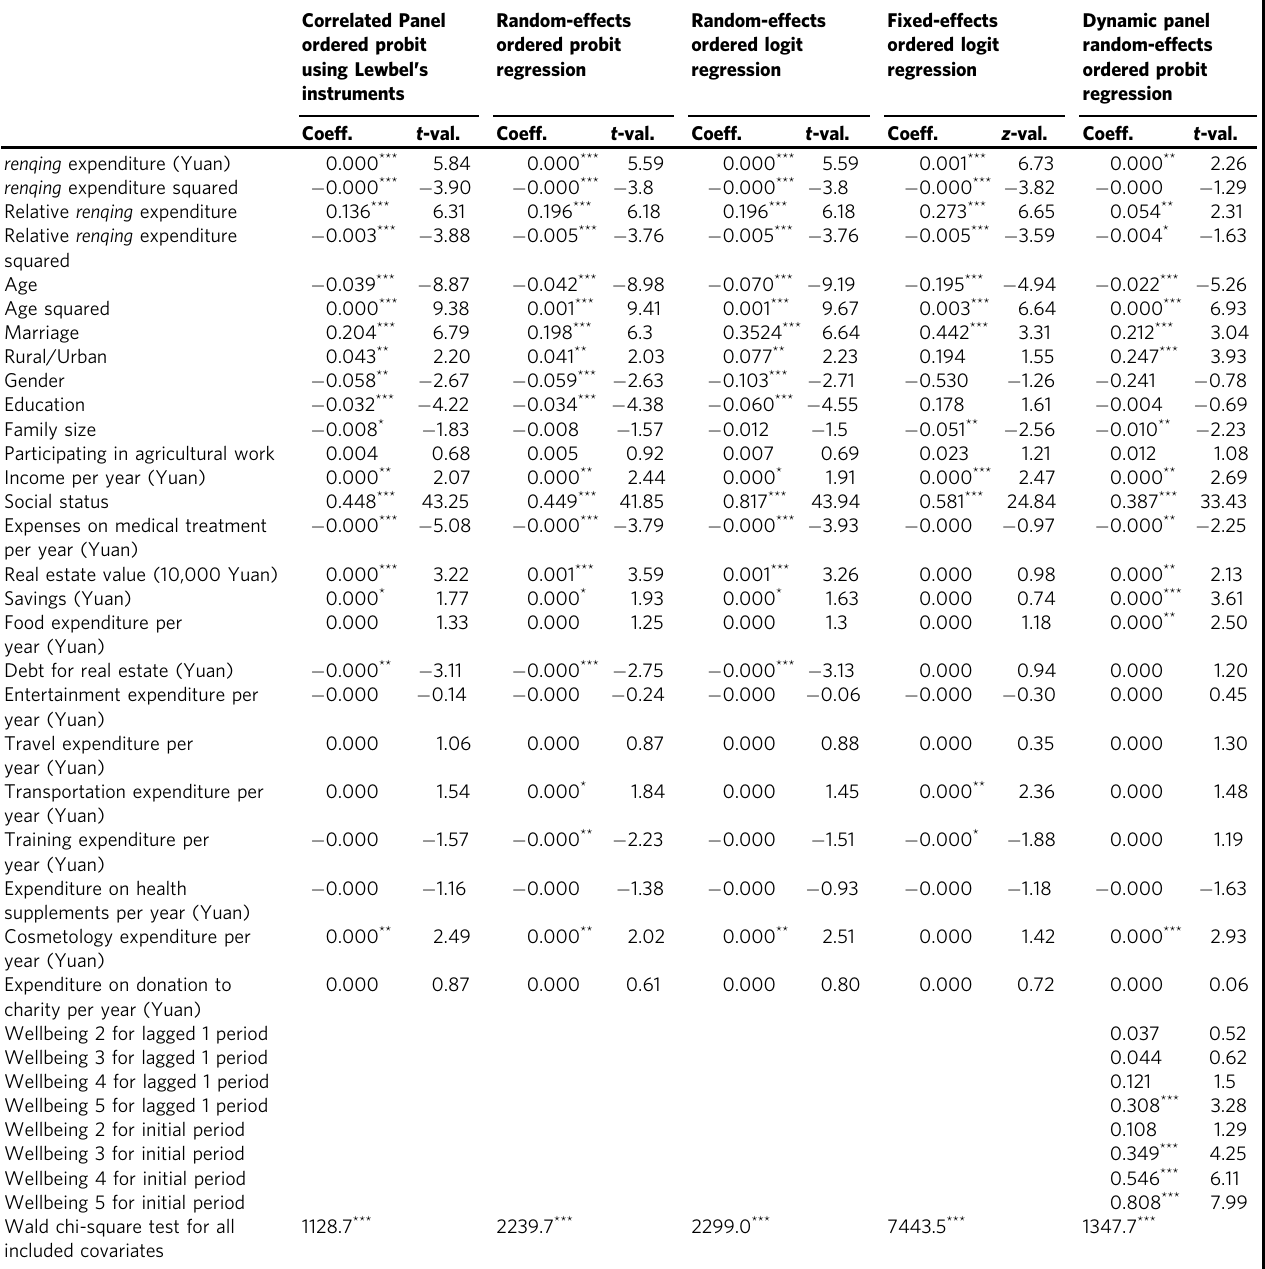
Table 4 Regression results with utility as dependent variable using Functions (7) and